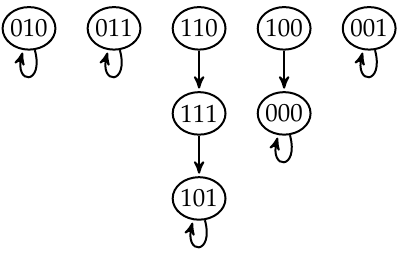
∨ x (cid:48) ) , x ∨ ( x ∧ x )) . 3 2 1 3 1